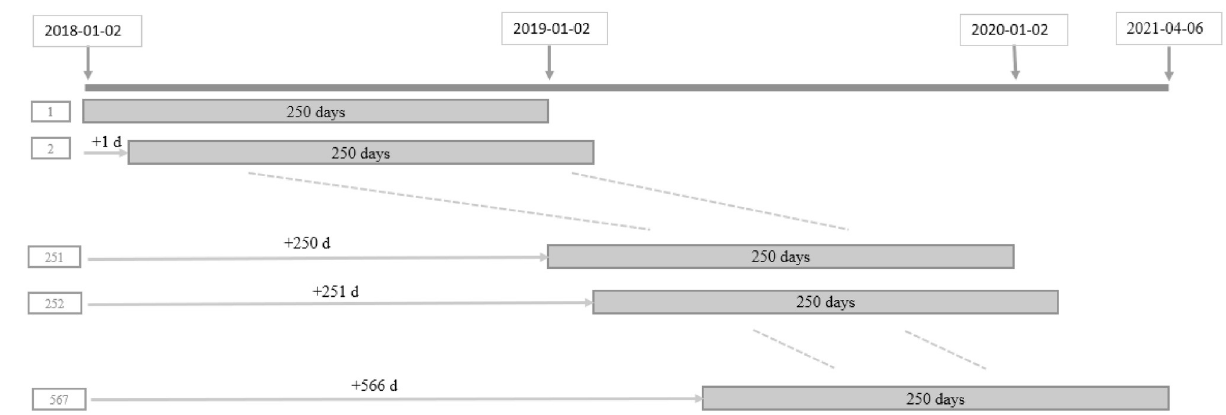
Fig 12. Schematic diagram of rolling window.